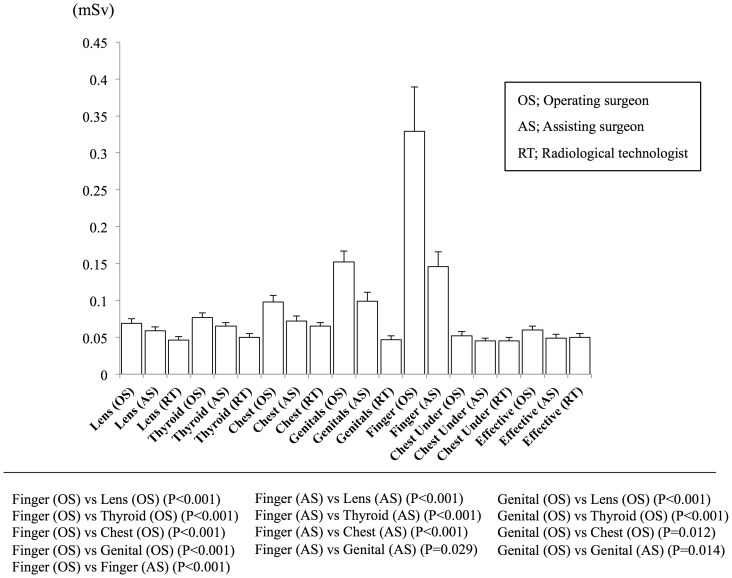
The mean radiation doses measured at different areas, and mean effective doses in all cases.The mean radiation doses and effective doses are shown for all cases. The mean radiation doses measured at the operating and assisting surgeons' right middle fingers were significantly higher than those measured elsewhere on the bodies. The mean radiation dose measured at the operating surgeon's genital area was significantly higher than at the lens, thyroid, or chest. Mean effective doses didn't differ significantly among the operating surgeon, assisting surgeon, and radiological technologist.